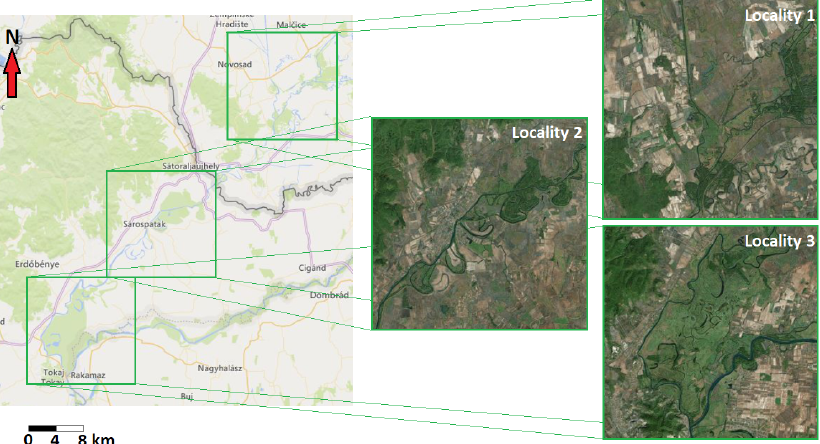
Figure 3. The selected localities of interest in the Bodrog basin.